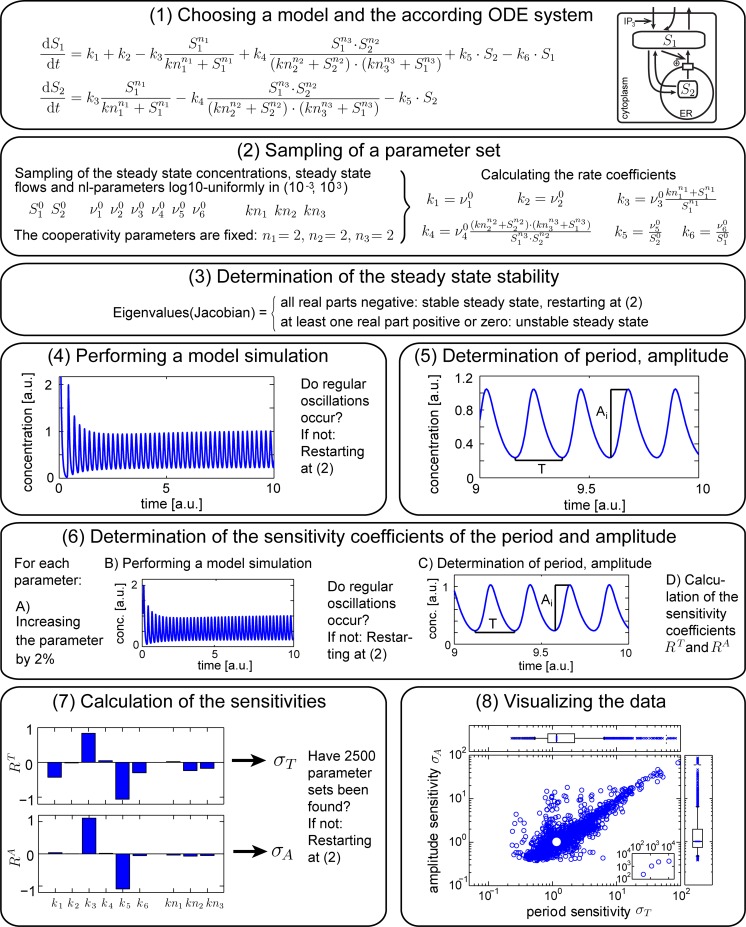
Work-flow of the analysis for the example of a calcium oscillations model [38].The analysis can be divided into eight parts. Details are described in Methods.